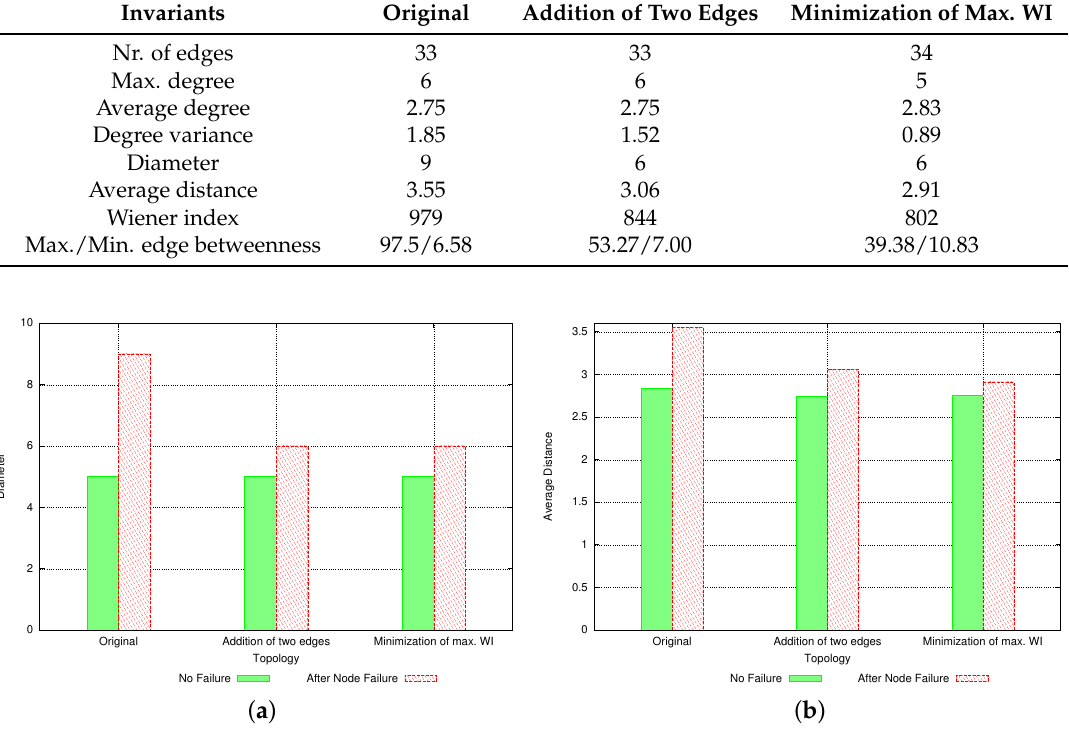
Figure 7. Invariants after the worst case node failure (max. WI): ( a ) diameter; and ( b ) average